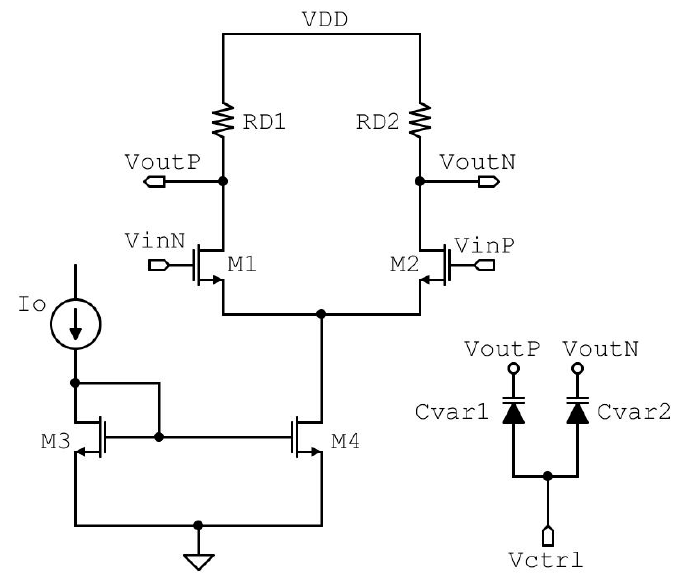
Figure 2. Circuit schematic of the single-stage, based on a Current Mode Logic (CML) buffer, of the ring oscillator and a couple of varactors connected at the two outputs.